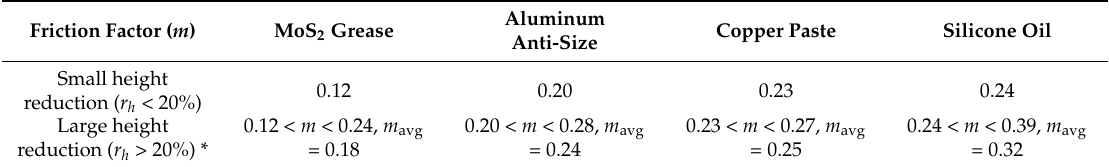
Table 3. Friction factors determined by the RCT according to reduction in height.